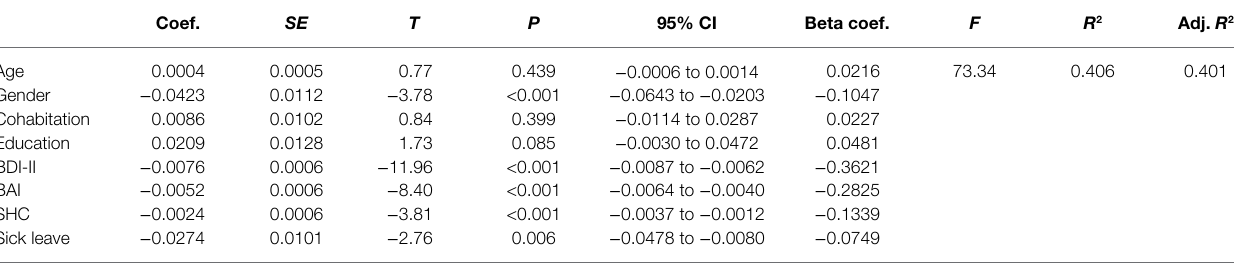
TABLE 7 | Regression analysis predicting the EQ-5D value ( N = 890). Coef. SE T P 95% CI Beta